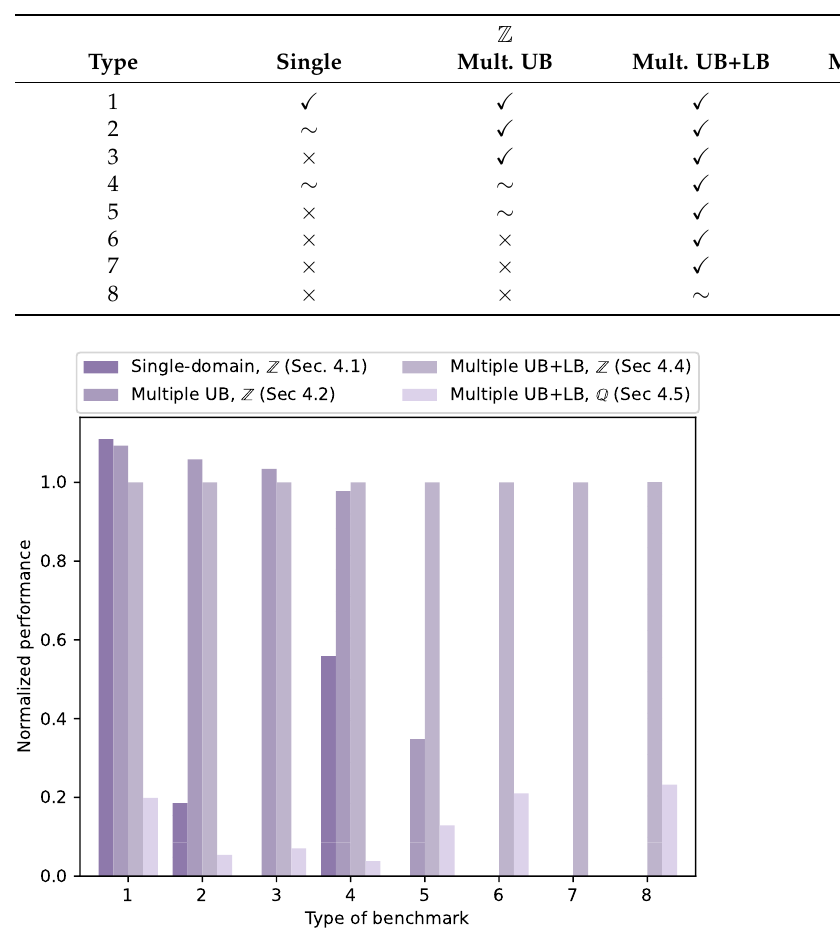
Table 2. Benchmark types used in Figure 10 according to reconstruction strategy coverage. The symbols (cid:88) , ∼ , and × indicate optimal, suboptimal (excess dimensionality), and failed reconstruction, respectively.